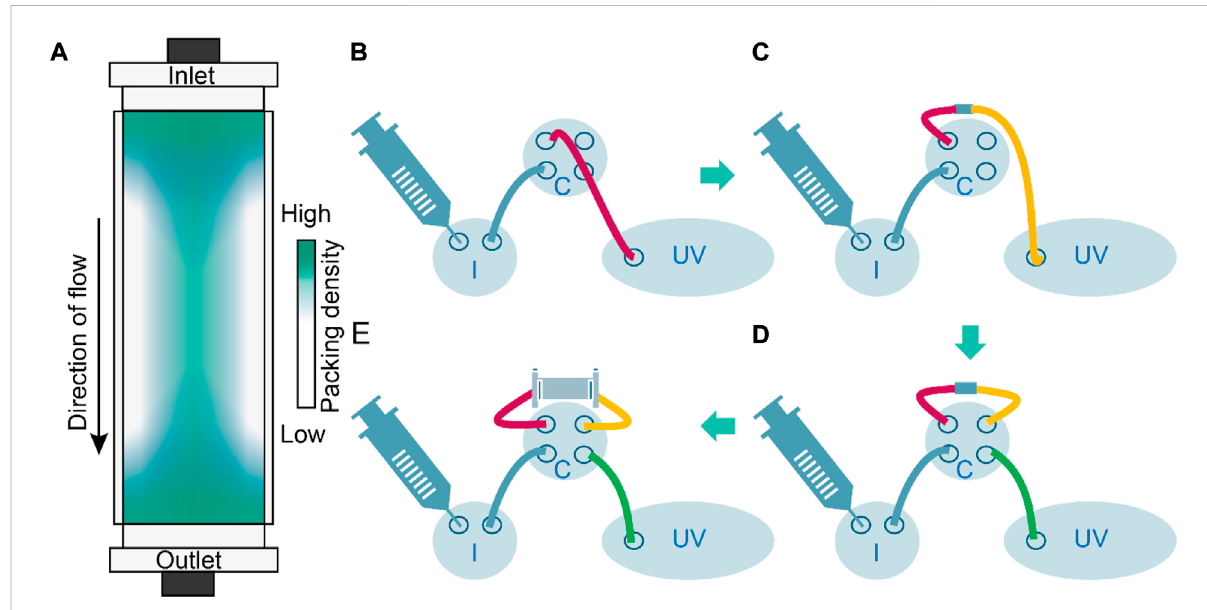
FIGURE 2 Columndensitydistributionandanalysisofpreandpost-columnvoidvolumestoassessaxialdispersioncausedbyinstrumentcomponents. (A) Schematic representation of the resin density distribution in a packed-bed column. Packing is densest in the column center, especially at column inlet and outlet whereas wall effects reduce the density. (B) Determination of void volume and axial dispersion up to the column inlet by connecting injection valve I and column valve (C) through a column inlet tube (red) directly to the UV monitor (UV); V pre-column = 21.7 × 10 − 5 L. (C) Determination of void volume and axial dispersion up to the column outlet by augmenting the setting in B with a column outlet tube (yellow) and a zero-volume connector; V column_outlet = 22.8 × 10 − 5 L. (D) Determination of void volume and axial dispersion using a bypass setting (zero volume connector instead of a column) including a connection from column valve to UV monitor (green); V zero_volume_connector = 30.0 × 10 − 5 L. (E) Determination of axial dispersion using a regular fl ow path including the column including the column peripheral liquid volume; V column_outlet = 106.6 × 10 − 5